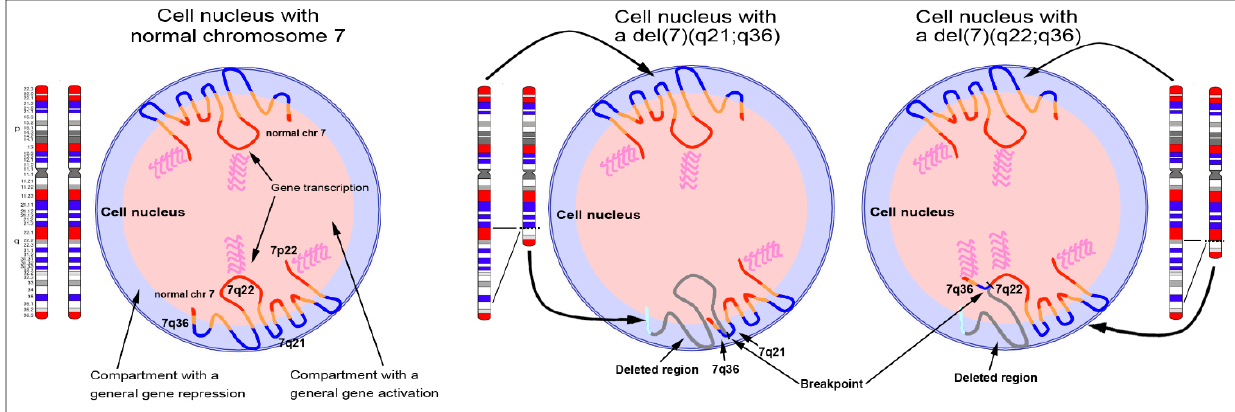
Figure 3. Effect of chromosomal rearrangements on gene expression. The image shows three nuclei with the zig-zag organization of the two chromosomes 7. Ideograms of the two homologous chromosomes 7 show the GC-richest (red) and the GC-poorest (blue) bands. The image shows three drawings of nuclei with two normal copies of chromosome 7 ( left ), one chromosome 7 carrying an interstitial deletion between 7q21 and 7q36 ( middle ), and one chromosome 7 with an interstitial deletion between 7q22 and 7q36 ( right ). Based on the new environmental conditions in which the terminal bands of chromosome 7 will be found after the deletion, activation of the genes involved in the rearrangement may occur, as observed for the MNX1 allele in patients with hematological disorders. The nucleus on the right shows the case of gene activation by repositioning the 7q36 band in a transcriptionally active compartment (close to the GC-rich 7q22 band), as opposed to what is presented in the nucleus in the center, where the deletion involving the GC-poor 7q21 band keeps the 7q36 band in the same transcriptionally inactive compartment. Modified from [97].